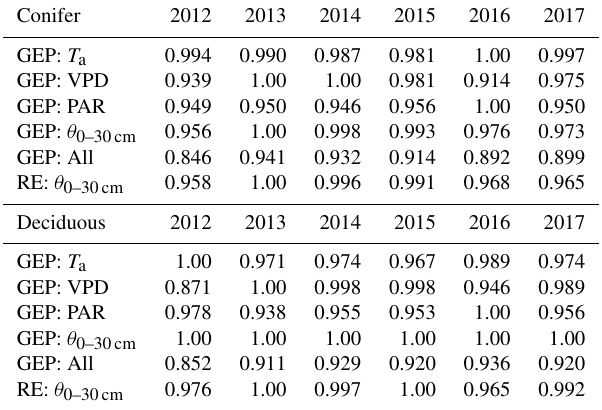
Table 5. Results of the two-step parameterization process used to explore interannual differences in controlling meteorological vari- ables (i.e., T a , VPD, PAR, θ 0–30cm ) and their impacts on annual RE and GEP during the phenological summer (end of greenup to the start of browndown) for the coniferous and deciduous forests from 2012 to 2017. These normalized values show the cumulative effect of the meteorological variable in reducing GEP and RE from their theoretical maximum values. Higher values (closer to 1) represent more favorable summer conditions for GEP and